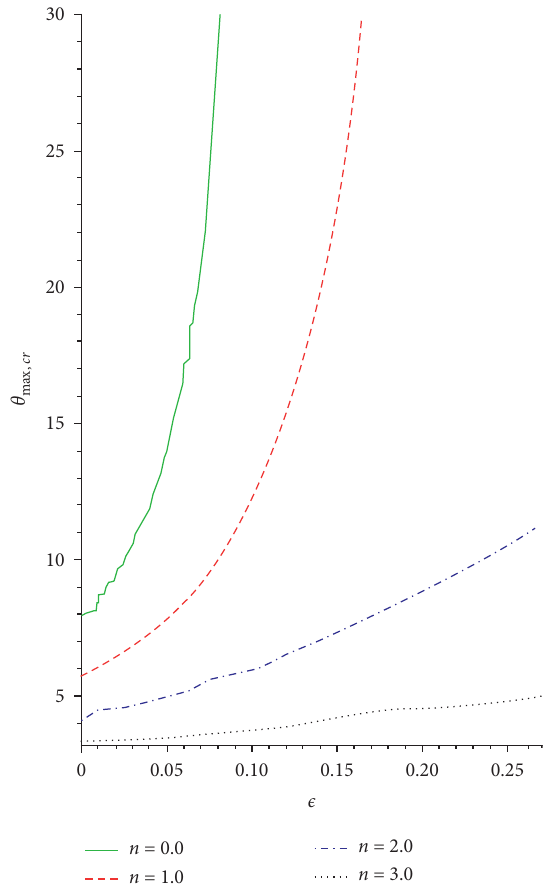
Figure 10: Plot of θ against ϵ for rising α . max ,cr Table 1: Comparison of results for the method of weighted residual collocation and numerical scheme.